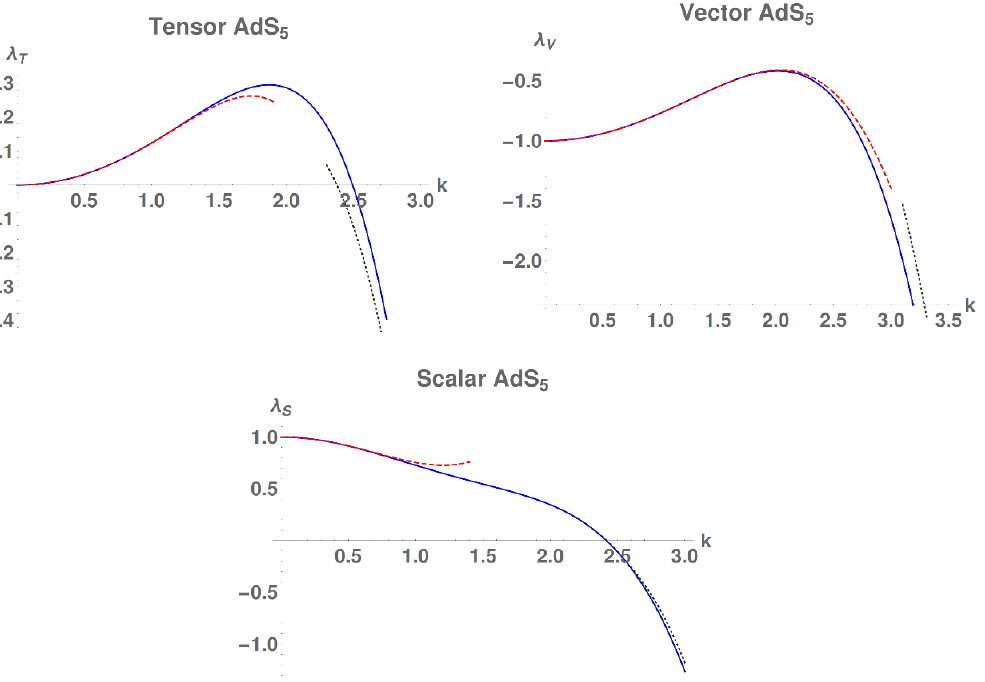
Figure 1 . Love numbers (cid:21) T;V;S for black branes in AdS 5 as a function of the wavenumber k . Solid blue: numerical results. Dashed red: perturbative expansions in powers of k , eqs. (5.1), (5.2), (5.3). Dotted green: large- k limit (4.5). We set R = 1, the Love numbers (cid:21) T;V;S are dimensionless, and k is measured in units of (cid:22) 1 = 4 = (cid:25)T .